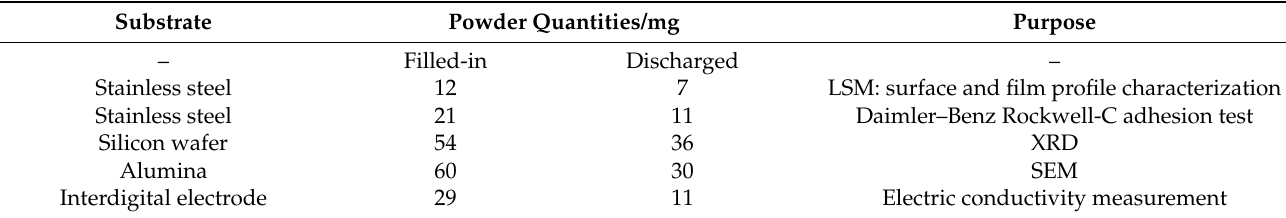
Table 1. Coated substrates with corresponding powder